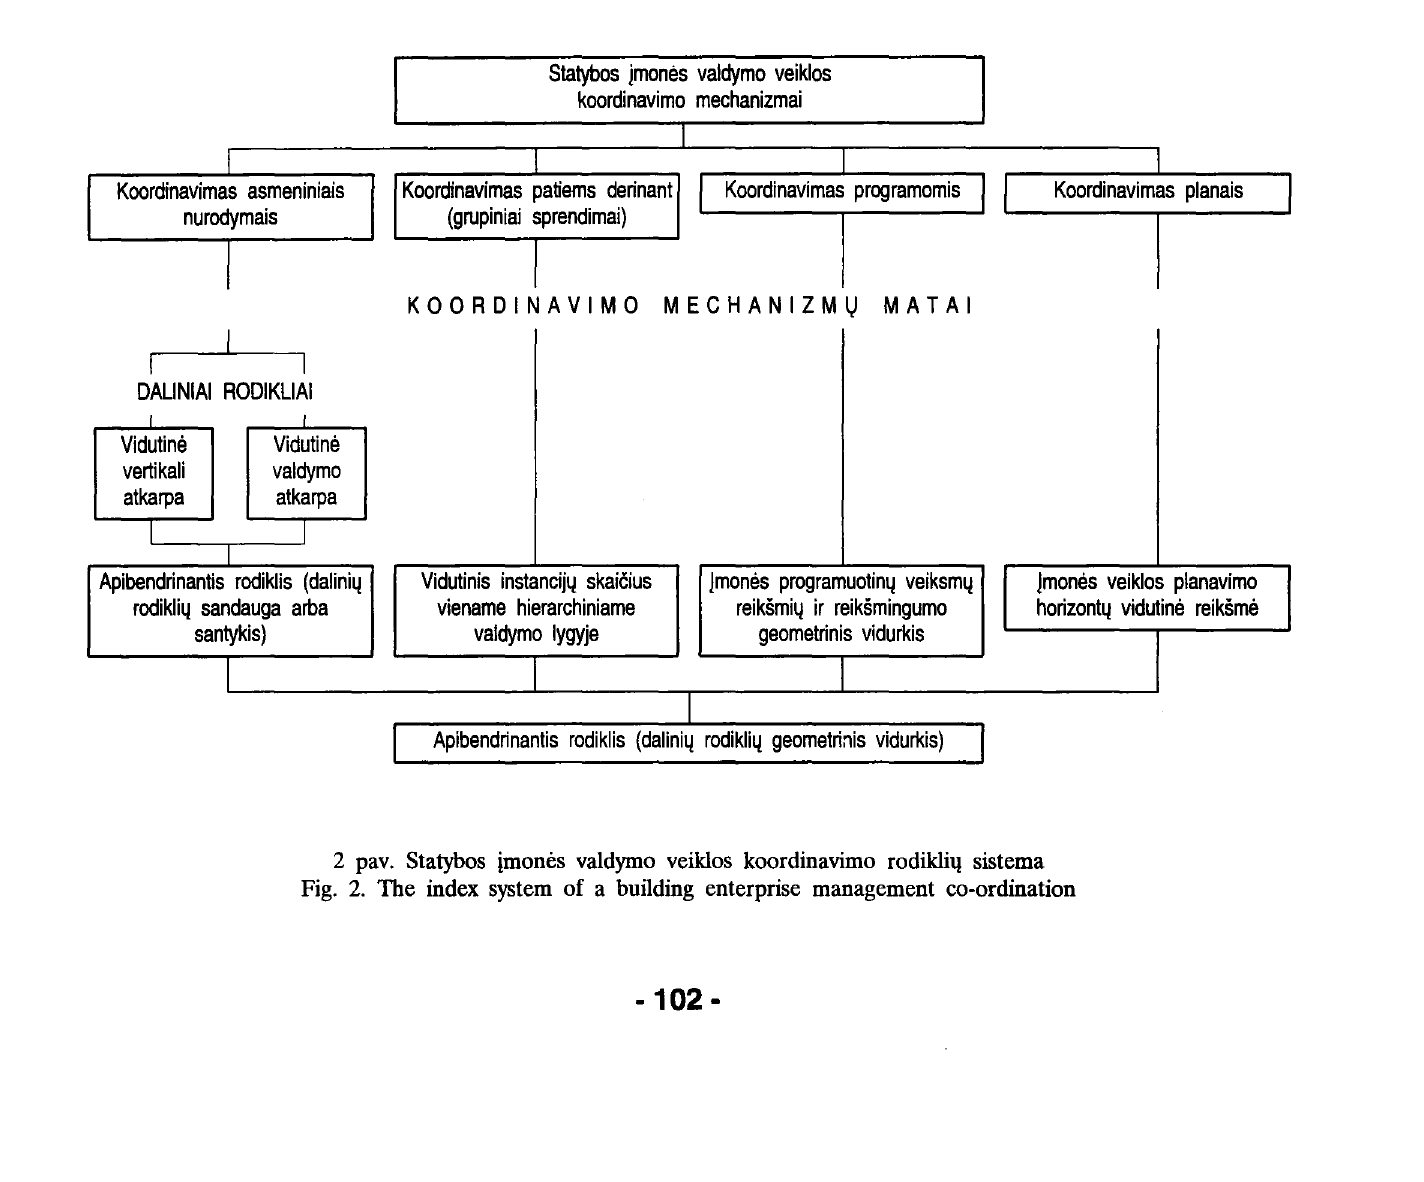
Fig. 2. The index system of a building enterprise management co-ordination